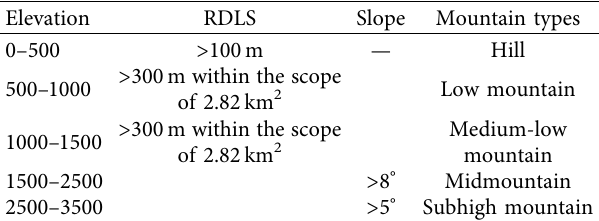
Table 1: Indicators of mountain type